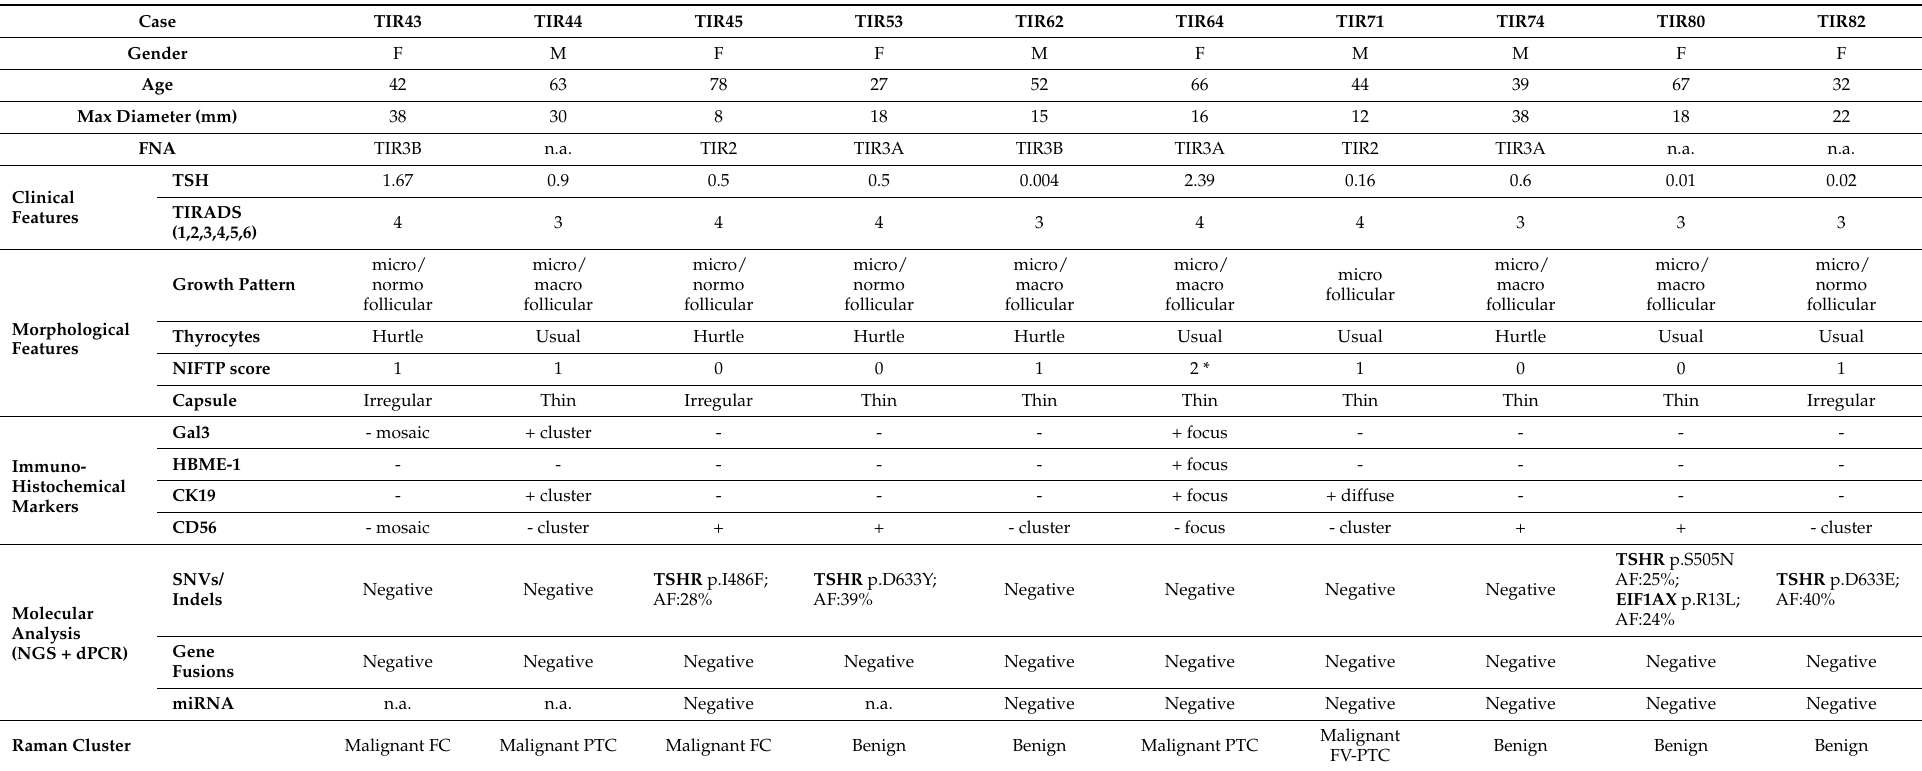
Table 1. Patients with follicular adenoma. Clinical features and morphological characteristics of the nodules. Legend: * Focus 1 mm PTC; n.a. not available, NGS,